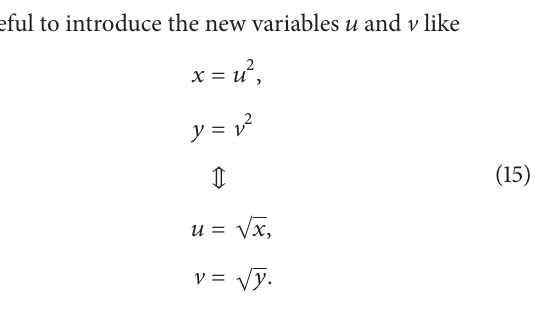
Figure 3: Illustration of the saddle-node bifurcation (part I) for the asymmetric pathway model. The stable fixed point given by 𝑦 (high) and 𝑥 (low) is about to merge with the unstable fixed point. Parameters: 𝐾 = 0.01 , 𝑟 1 = 2.2 , and 𝑟 2 = 1.8 .